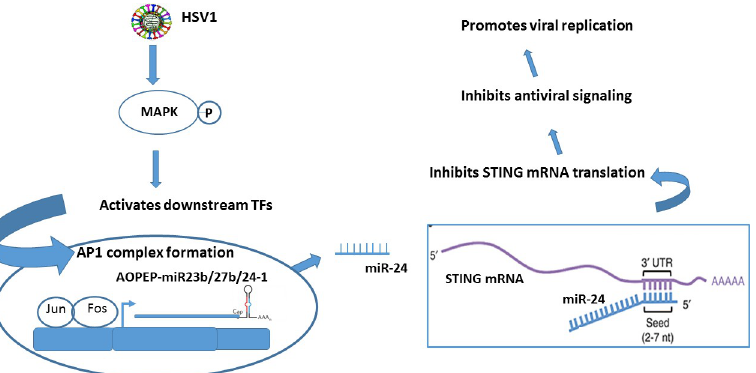
Fig 8. Model summarizing the regulatory role of miR-24 in HSV1 induced STING signaling. The model depicts the regulation of STING protein levels by HSV1 induced miR-24 expression which inhibits STING signaling and promotes viral replication. HSV1 infection activates MAPKs which enhance the expression of AOPEP mRNA and miR-23b, miR-27b, miR-24 leading to miR-24 accumulation and targeting of STING signaling. This acts as an immune evasion strategy adopted by the virus to augment its own